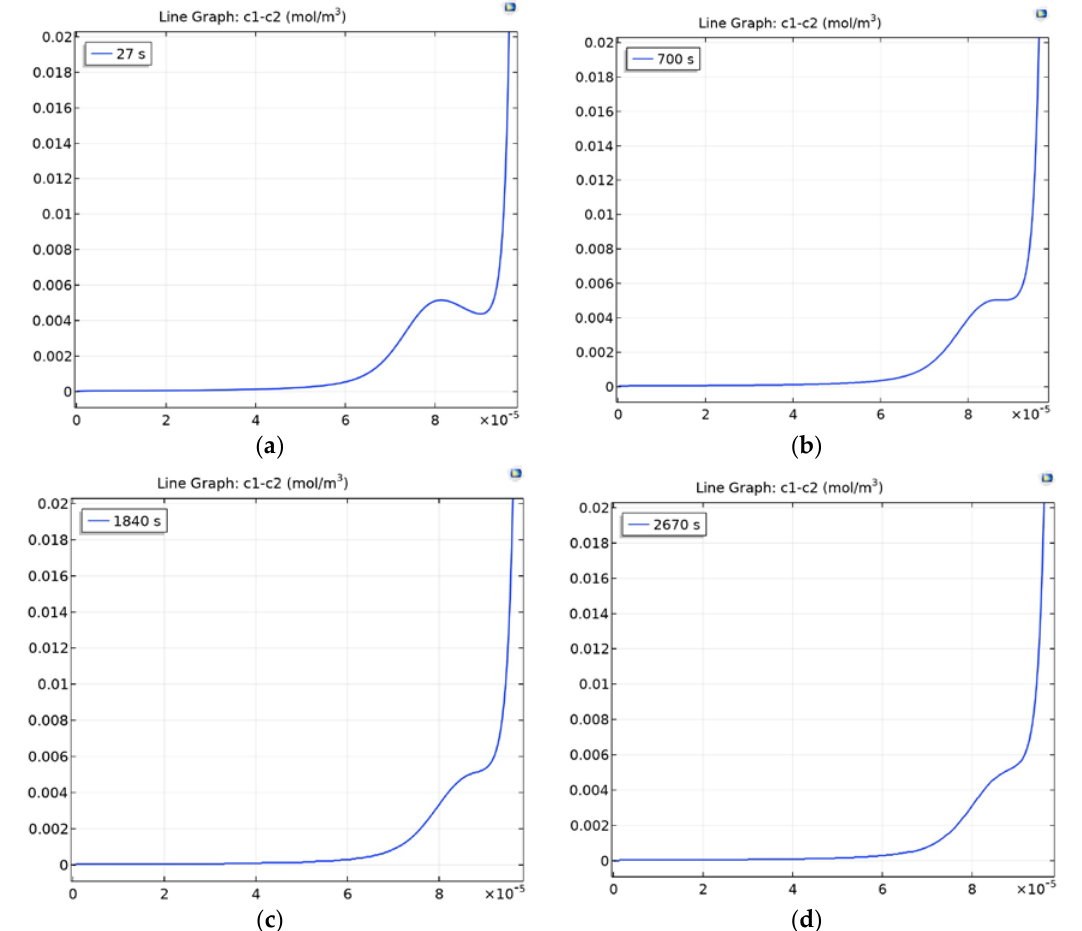
Figure 2. Dependence of the local maximum on the exchange capacity of the CEM (NaCl, ∆ r φ = 0.5): ( a ) C 1 m = 14, ( b ) C 1 m = 350, ( c ) C 1 m = 920, ( d ) C 1 m =